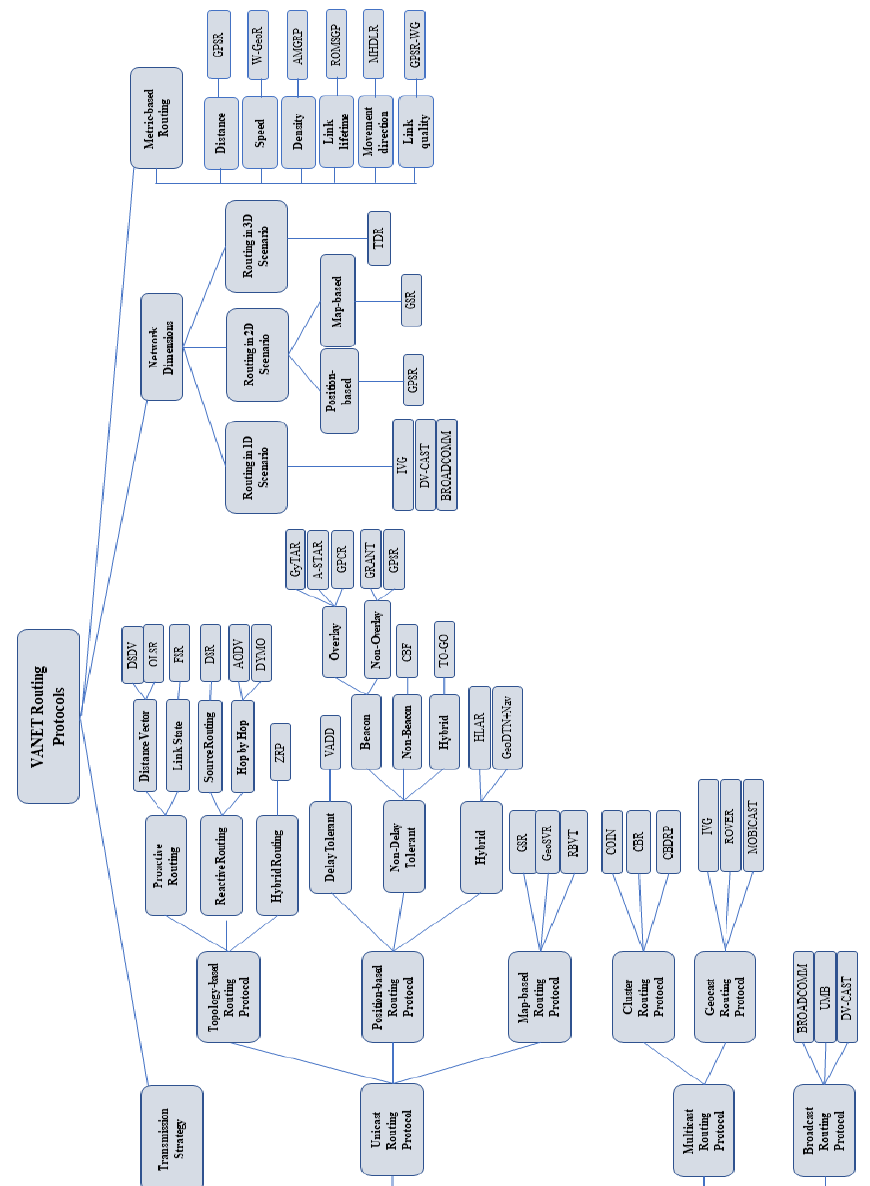
Figure 2. VANET routing